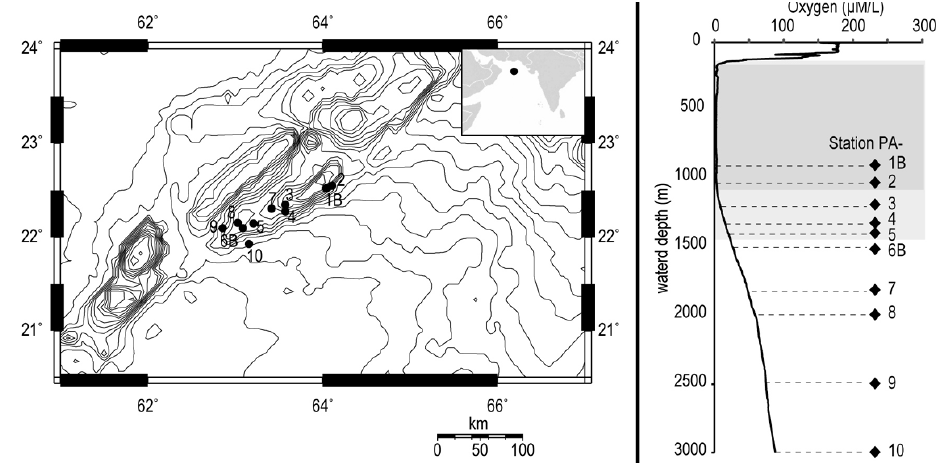
Fig. 1. Left: map of Murray Ridge, Arabian Sea, showing the station locations with an annex of the Indian Ocean with the Murray Ridge indicated with a solid symbol. Right: water-column profile of dissolved oxygen in the study area. Water depth and BWO content of each station shown. Dark grey shaded area = core of the OMZ, BWO content < 5µM; light grey shaded area = OMZ, BWO content < 22µM (or 0.5mLL − 1